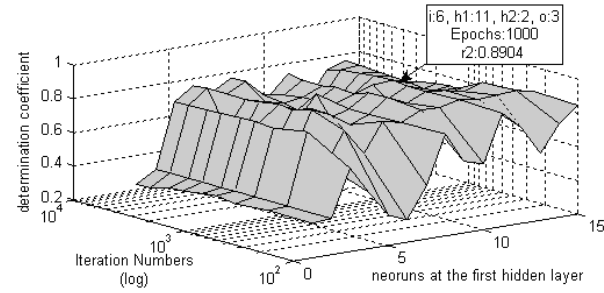
Fig. 8. 3-D surface of determination coefficients.